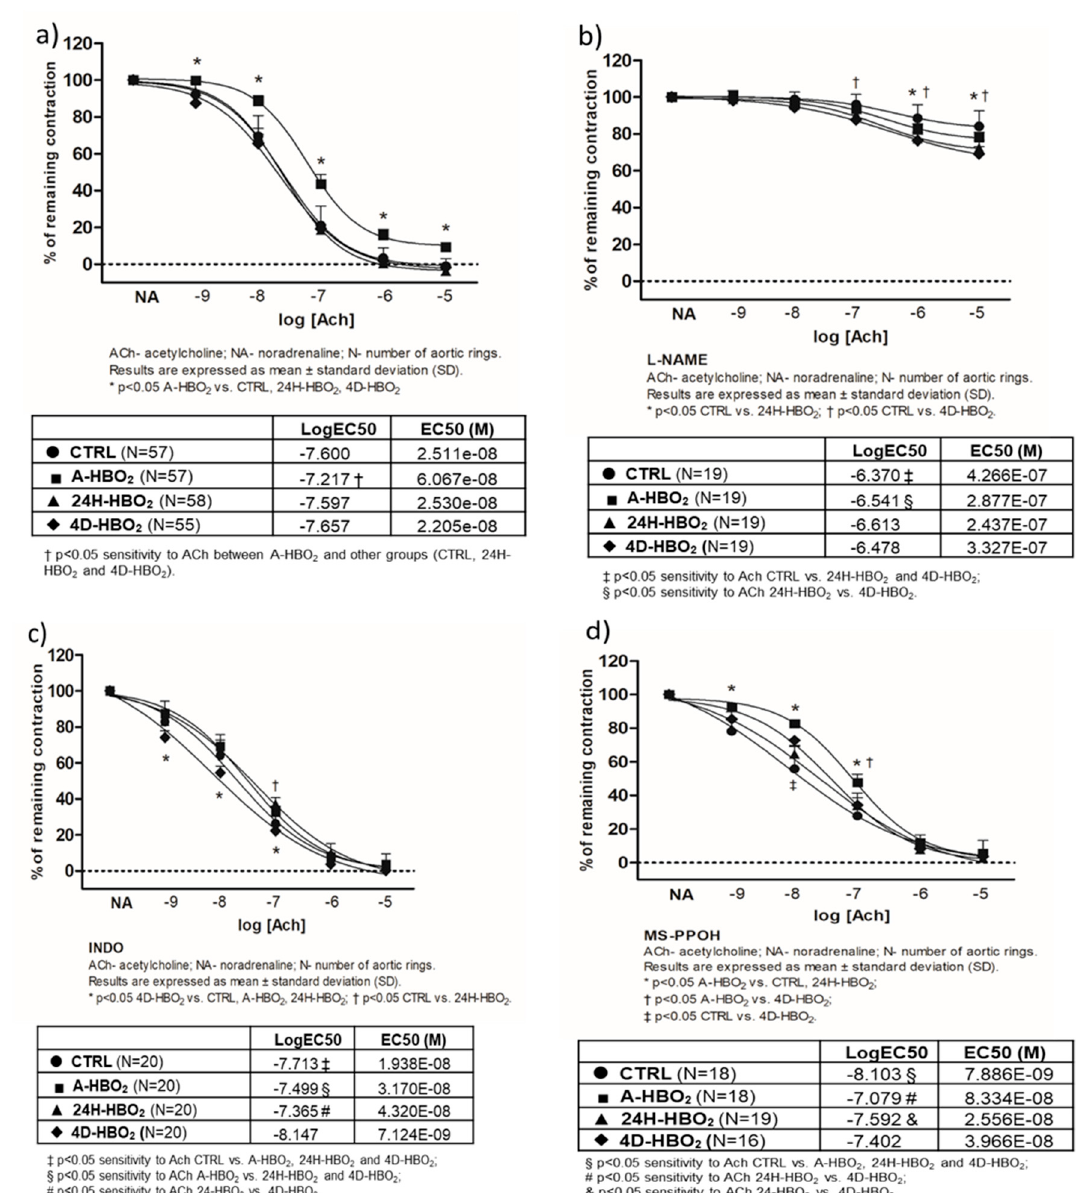
Figure 1. Ach-induced relaxation (AChIR) of isolated rat aorta rings in the CTRL, A-HBO 2 , 24H-HBO 2 and 4D-HBO 2 groups. Baseline relaxation to acetylcholine ( a ) and relaxation to acetylcholine in the presence of eNOS inhibitor L-NAME ( b ), COX inhibitor INDO ( c ) and a selective CYP450 epoxidase inhibitor, MS-PPOH ( d ) in CTRL, A-HBO 2 , 24H-HBO 2 and 4D-HBO 2 groups of rats. Results are presented as mean ± SD; N – number of aortic rings; p < 0.05 .